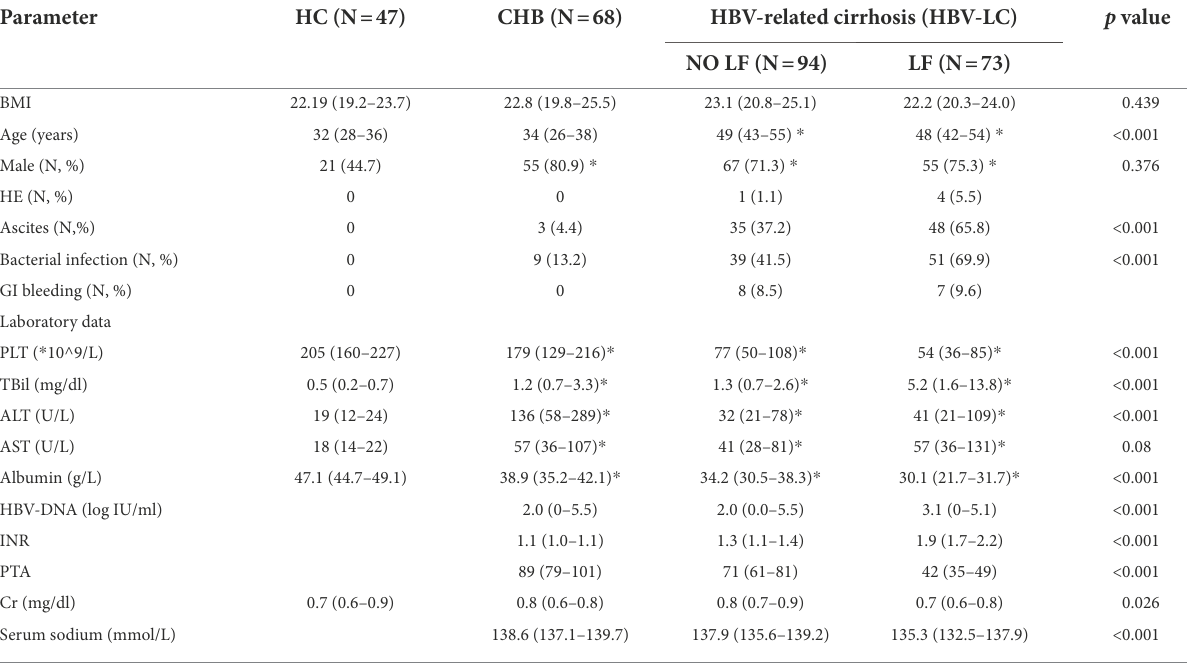
TABLE 1 Baseline characteristics of all enrolled subjects.